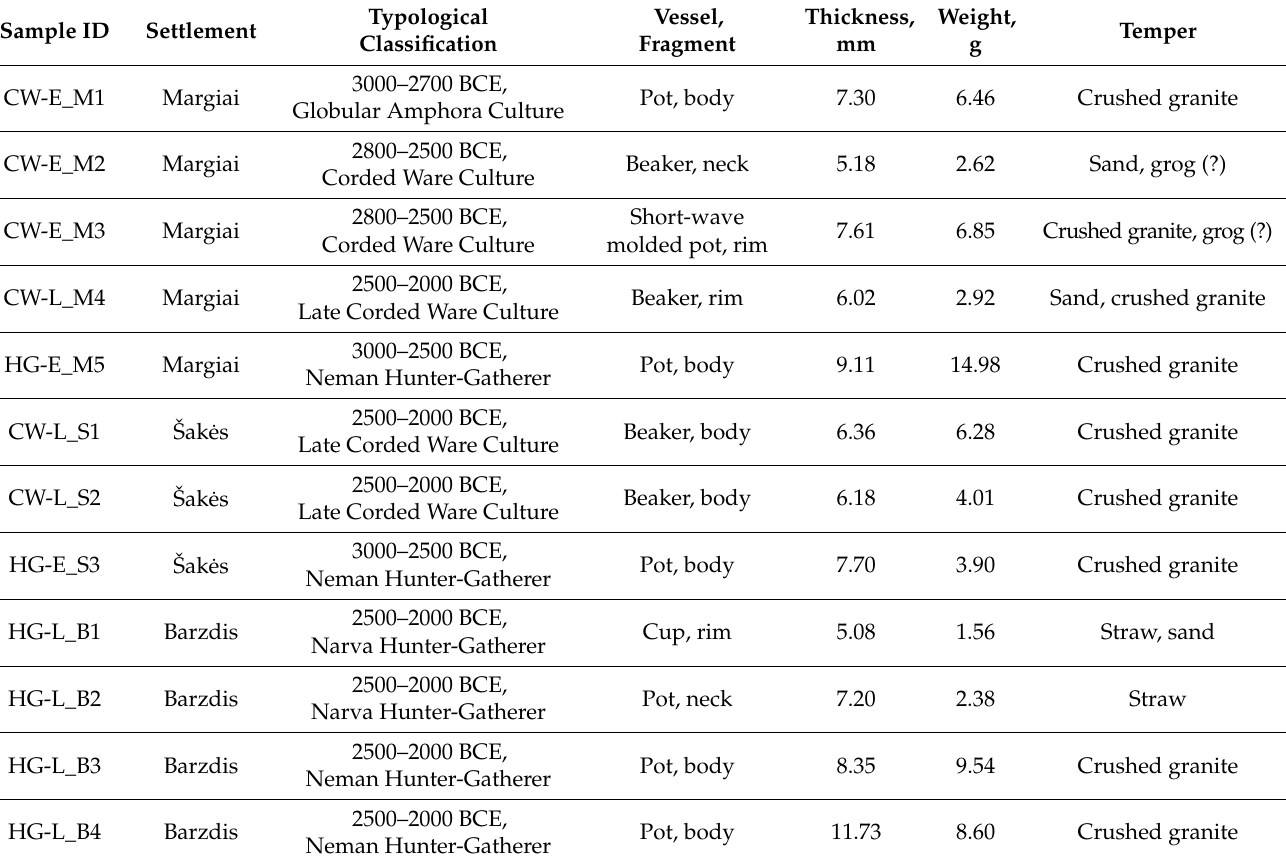
Table 1. A description of the studied pottery samples. The samples are labeled as early (or late) cord- decorated pottery—CW-E . . . (or CW-L . . . ) or as early (or late) 3rd millennium BCE hunter-gatherer pottery—HG-E . . . (or HG-L . . . ) plus the site initial (M, S, or B) and the sample